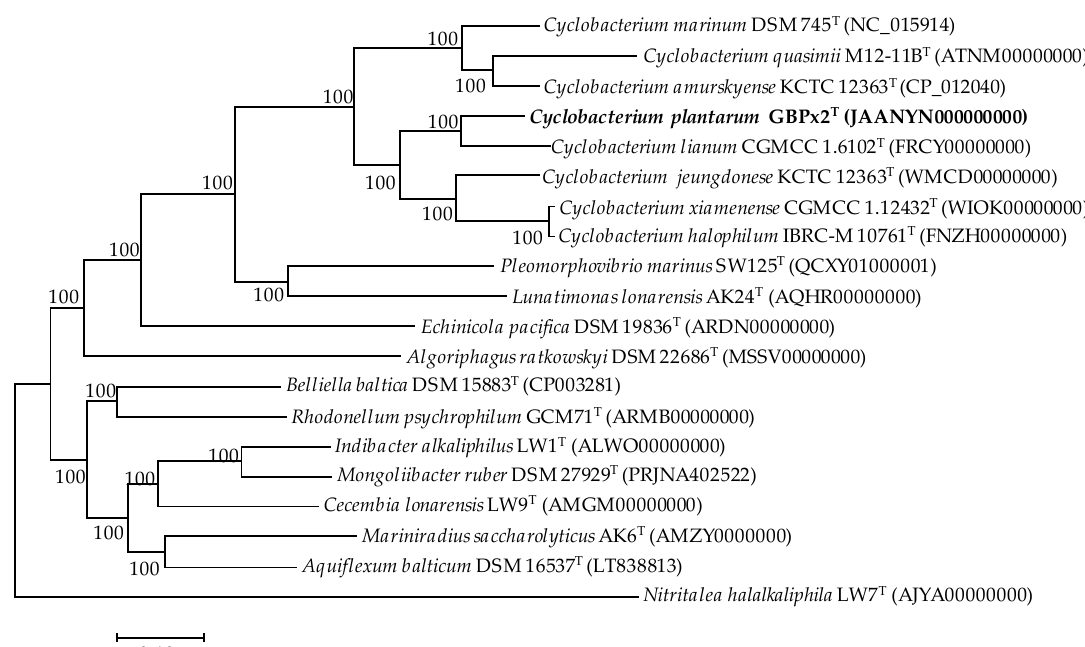
Figure 2. Phylogenomic tree based on the core orthologous translated genes of strain GBPx2 T , type species of Cyclobacterium , and type species of the genera of the family Cyclobacteriaceae obtained from the genomes available in databases, based on the maximum-likelihood algorithm. This tree was obtained after the alignment of 1309 shared orthologous single-copy translated genes of these genomes. Bootstrap values higher than 70% are indicated at branch-points. Bar, 0.1 substitutions per amino acid position.